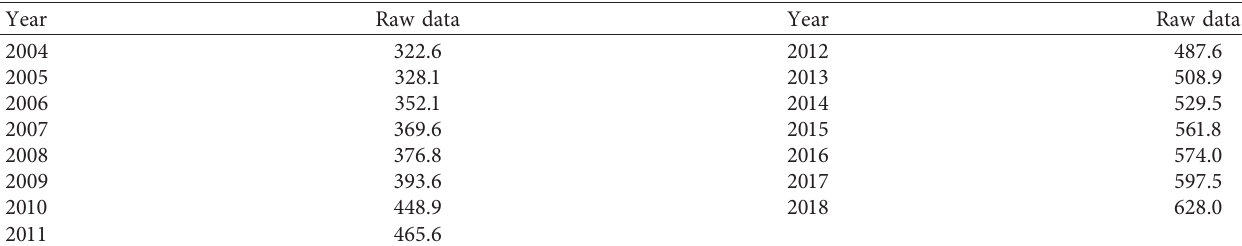
Figure 3: Track of seeking for the optimal parameters of the GM(1,1, t α ) model (a) and the novel model (b). Table 3: Annual oil consumption of China form 2004 to 2018